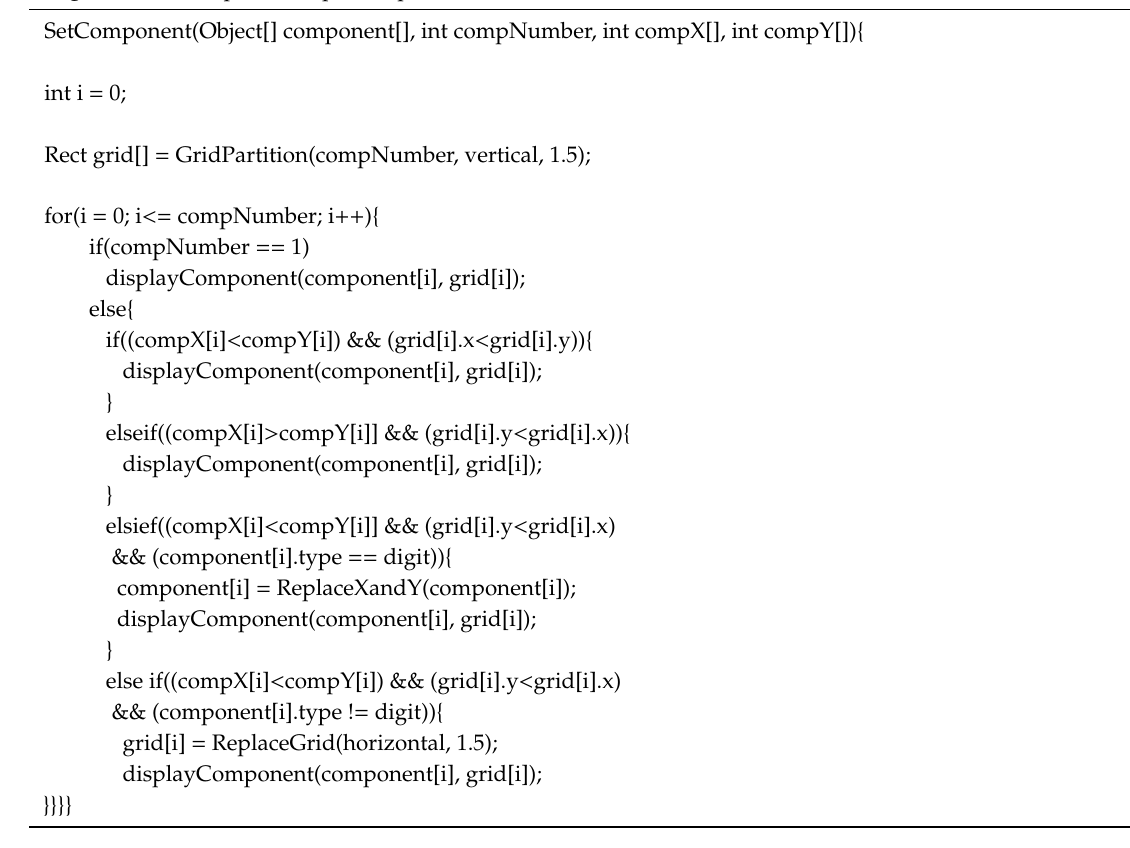
Algorithm 3. Adaptive component